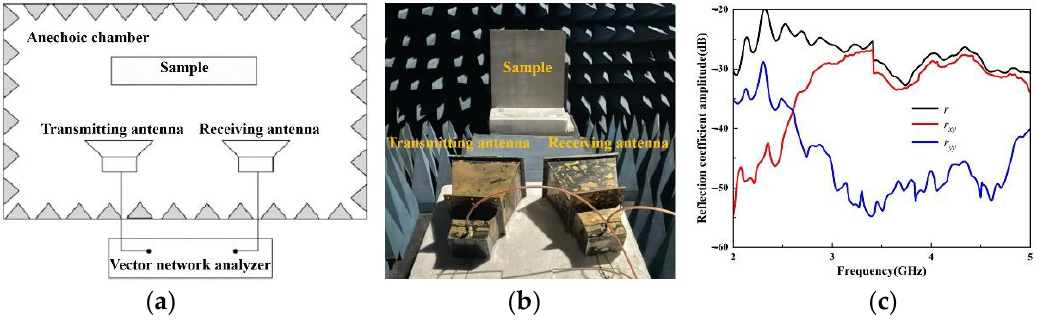
Figure 6. Experimental environment and measurement data. ( a ) Diagram of measurement. ( b ) Mea- surement setup in the microwave anechoic chamber. ( c ) Measured reflection wave